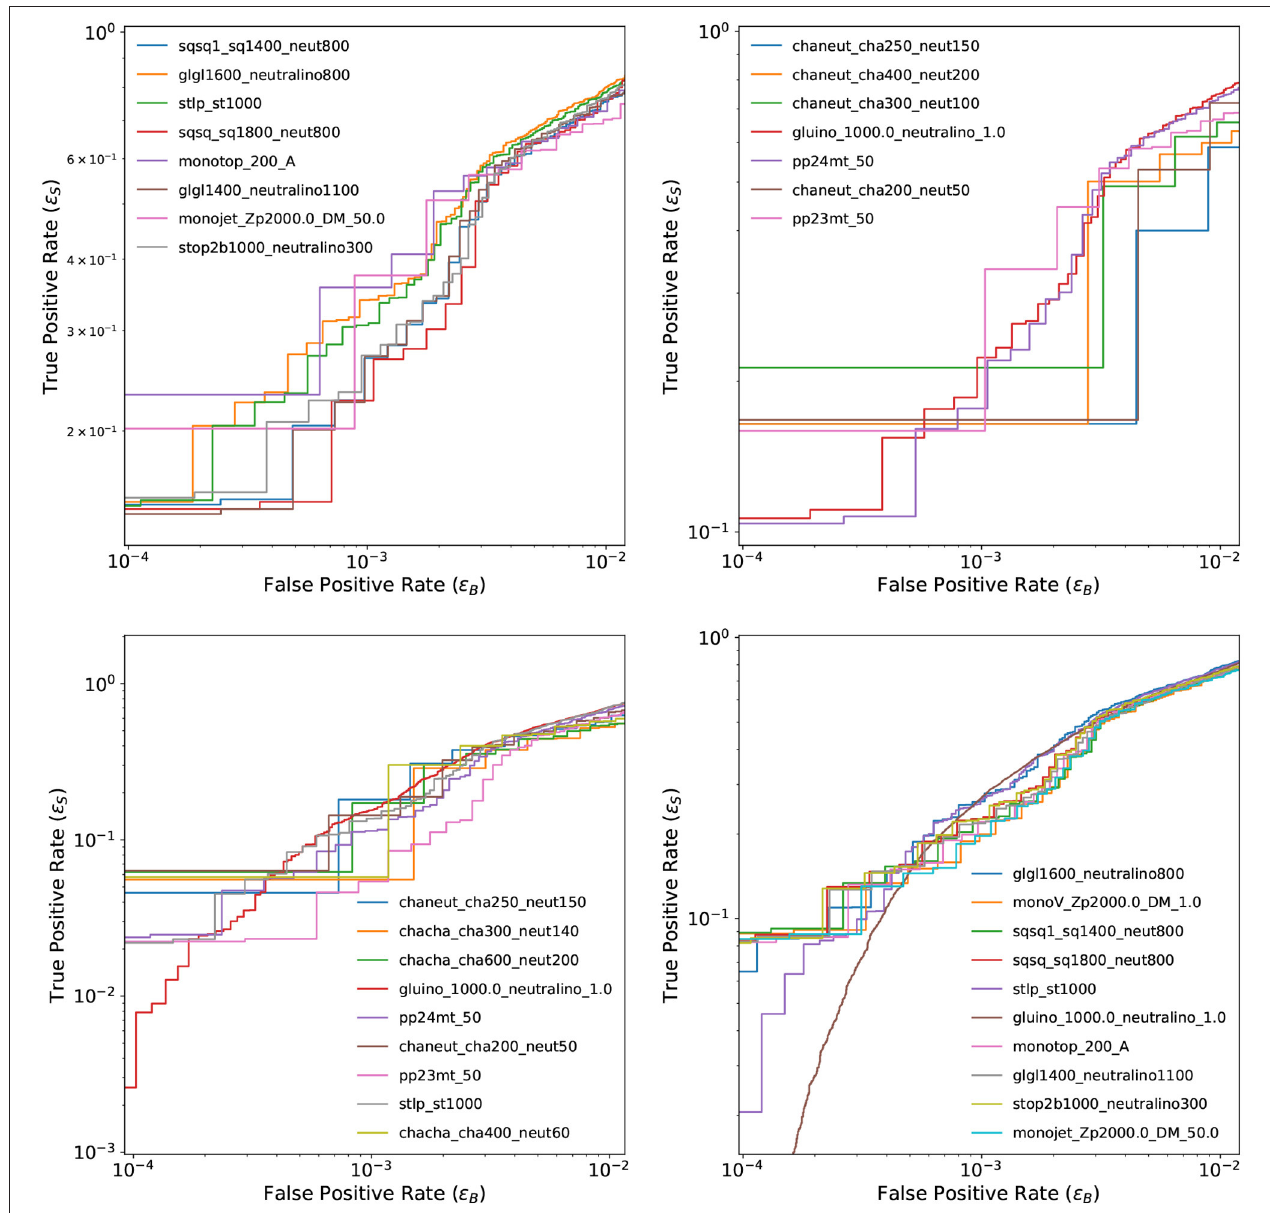
FIGURE 7 | ROC curves of GCN-VAE_HouseholderSNF for all signals in each of channel 1 (top left), channel 2a (top right), channel 2b (bottom left), and channel 3 (bottom right).